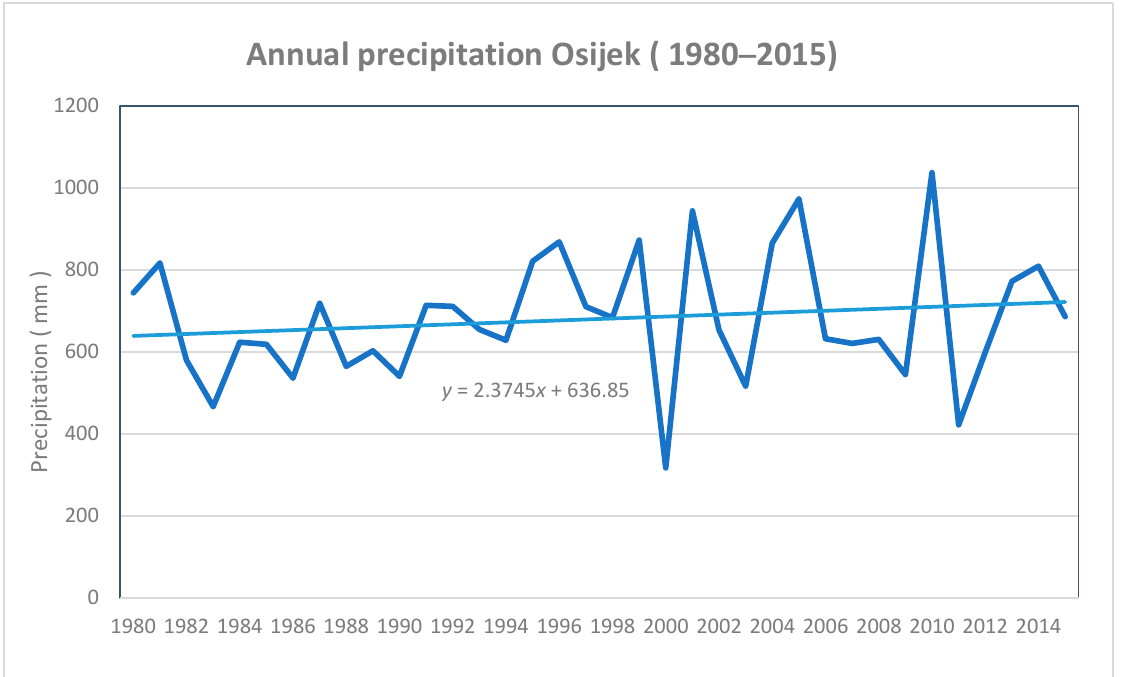
Figure 5. Annual precipitation for Osijek, Croatia for the period 1980–2015. The climate diagram for Osijek, Croatia for 2000 confirms the characteristics of weather conditions were in the “extreme” category (Figure 6). The drought period according to the Walter–Lieth climate diagram prevailed for almost the whole year. The wet period occurred in January, February, March, and December. The year 2000 was classified as being both extremely warm and extremely dry, according to the deviation of the average annual air temperature and the annual amounts of precipitation, respectively.